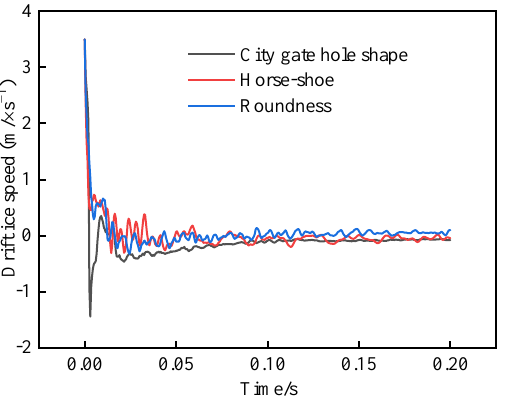
Figure 19. Velocity time – history curves of flowing ice under different cross-sections.